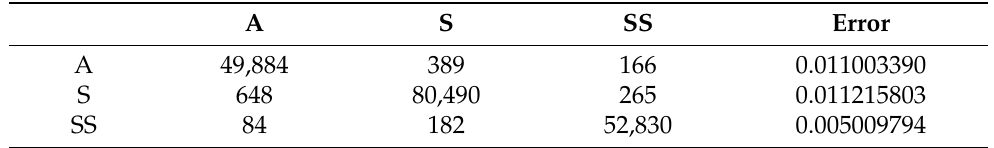
Table 9. The result of the confusion matrix with the Random Forest